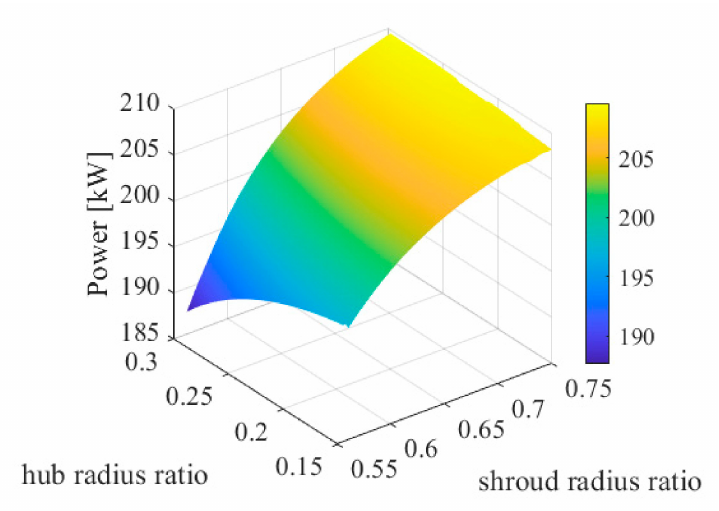
Figure 13. Variation of enthalpy losses with α 2 and number of blades.